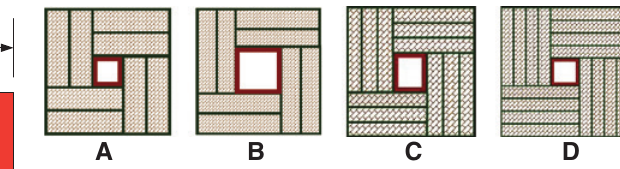
Figure 5: Composite cross sections of compressive